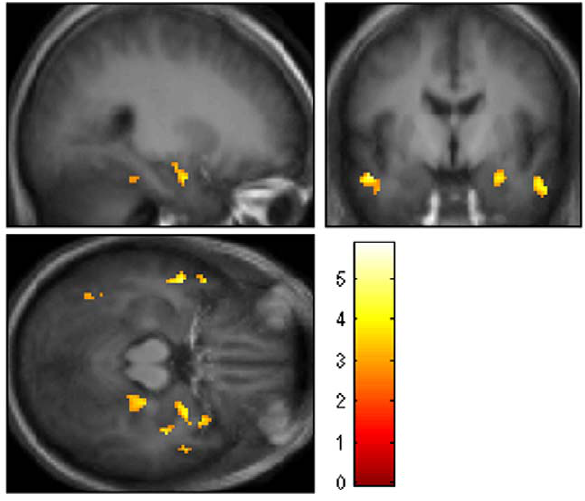
Figure 3. Brain regions showing significant positive correlation between the duration of nocturnal hypoxemia and effects of task load in DMN (ie, regions where increased duration of nocturnal hypoxemia correlates with less effective deactiva- tion of DMN regions with increasing task load; MNI coordi- nates, corrected for multiple comparisons, p=0.05, neurolog- ical presentation).